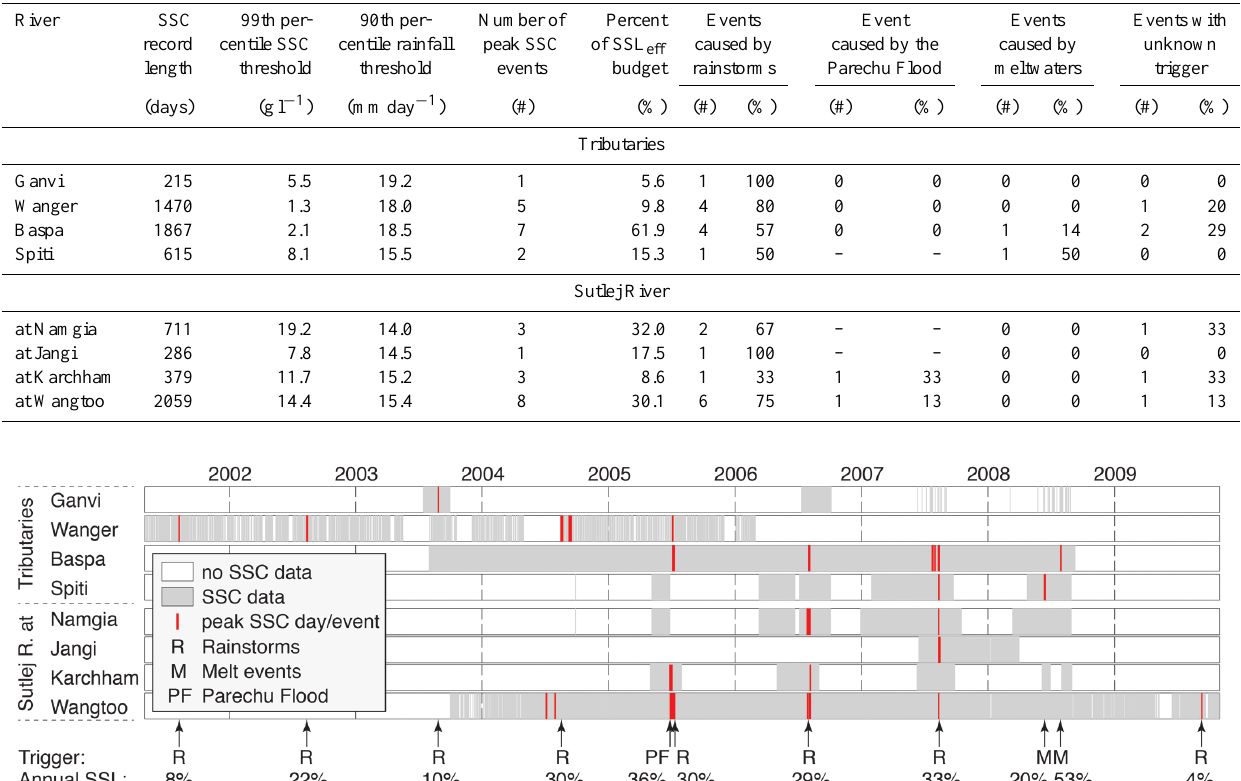
Table 4. Peak suspended sediment concentration (SSC) events and their relation to rainstorms ( > 90th percentile), the Parechu Flood , and during the Parechu Flood. Note the variable length of the records and that SSC records of the Ganvi River, Spiti River, and the Sutlej River at Namgia and Karchham refer to the summer half-year only.